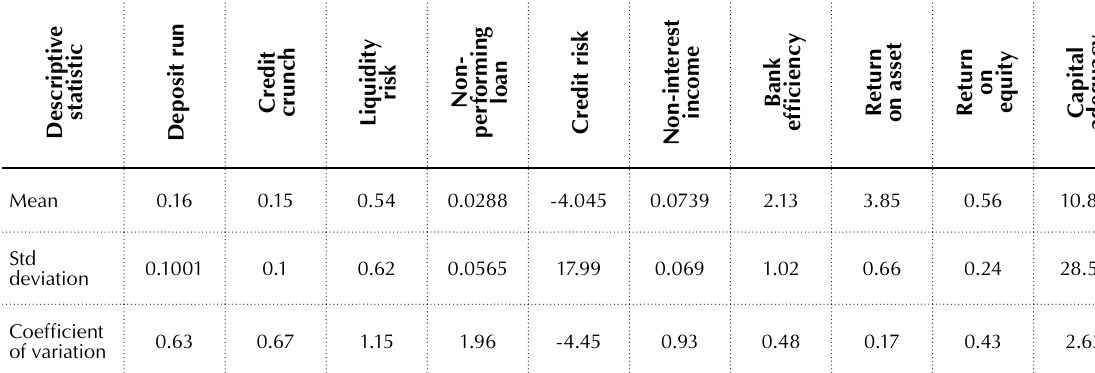
p t i c r e s D